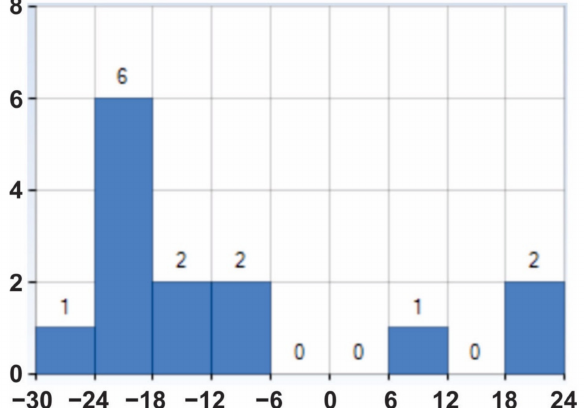
Figure 20. The NSEF strengths distribution for the TGE events accompanied by light